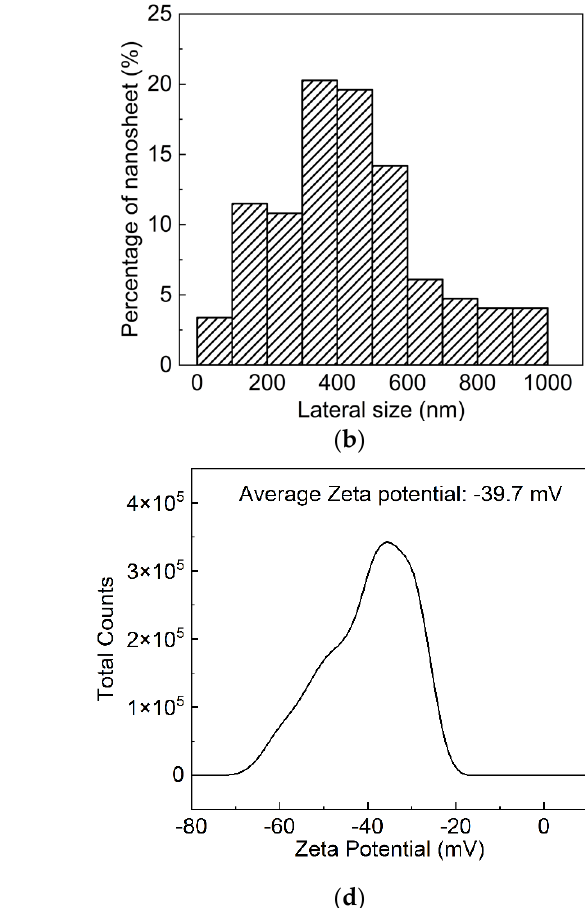
Figure 1. Characterization of CNO nanosheets. ( a ) AFM image of CNO nanosheets and height profile of an individual nanosheet across the white line; ( b ) size distribution of CNO nanosheets (about 1000 samples were counted); ( c ) Zeta potential distribution; ( d ) hydrodynamic size distribution of Ca 2 Nb 3 O 10 nanosheets in water.